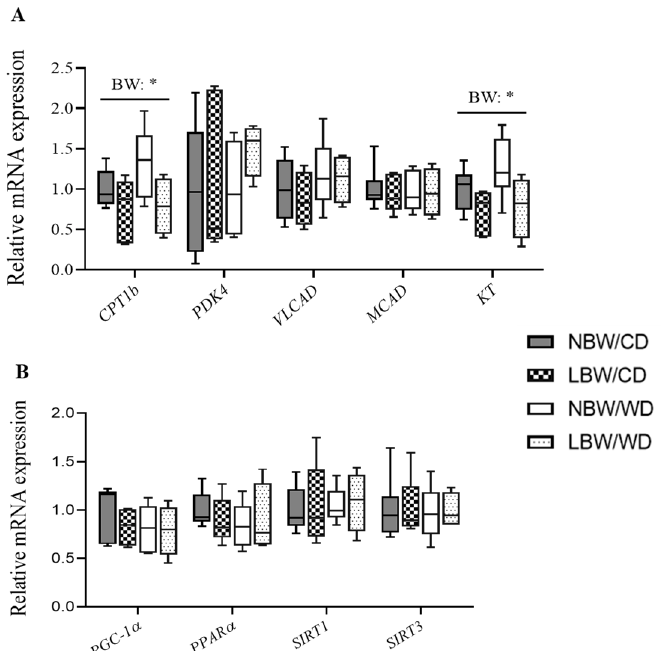
Figure 11. mRNA expression of genes involved in mitochondrial β -oxidation and biogenesis at postnatal day 145. Panel ( A ) shows mRNA expression of genes of mitochondrial β -oxidation; panel ( B ) indicates mRNA expression of transcription factors regulating mitochondrial β -oxidation genes. Data are min. to max. box and whisker plots for n = 4 to 6 animals per group. * for p < 0.05 represents the main effect of birth weight (BW) using a regular two-way ANOVA.